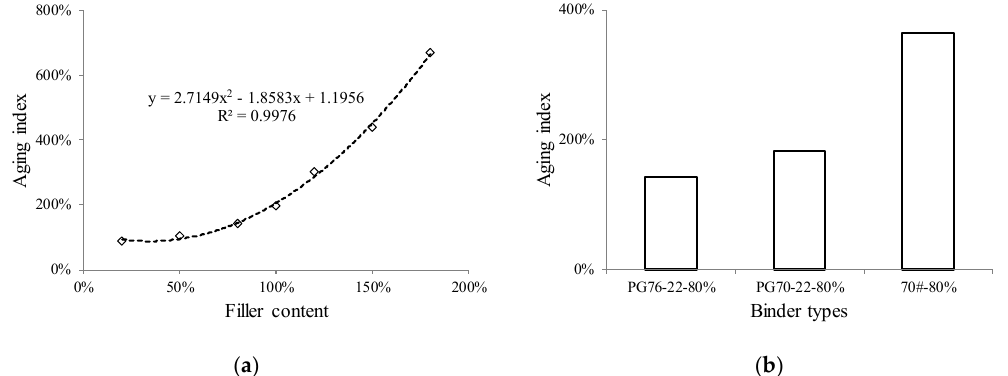
Figure 8. The aging index of different mastics: ( a ) effect of filler contents on the PG76-22 mastics; ( b ) effect of binder types.